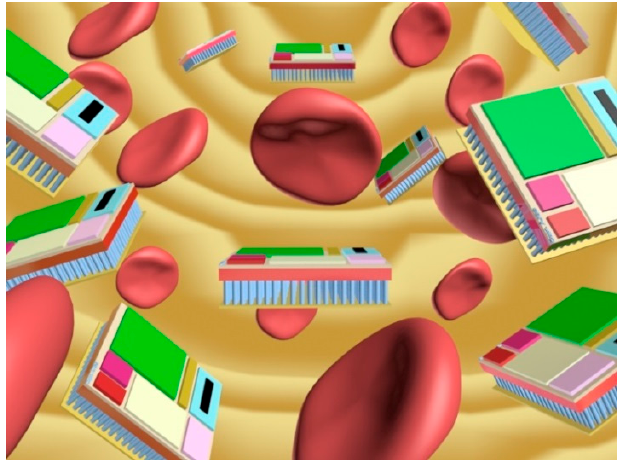
Figure 1. Nanodevices flowing through the bloodstream.